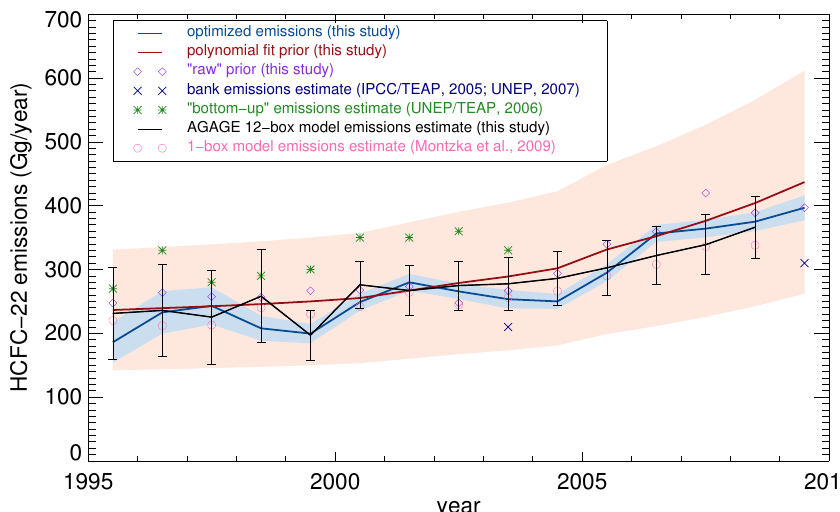
Fig. 3. Global total HCFC-22 emissions. Prior emission estimates using EDGAR v4, the growth rate between 1990–2000 (McCulloch et al., 2003), and HCFC-22 consumption between 2001–2009 (UNEP, 2011) are shown in diamonds. Polynomial fit of these “raw” prior values that we used in our global inversion are shown as a red line with a shaded (pink) 40% uncertainty range. Optimized emissions from this study are shown in blue with our calculated posterior uncertainty. Previously published bank emission estimates (blue crosses) (IPCC/TEAP, 2005; UNEP, 2007), “bottom-up” emission estimates (green stars) (UNEP/TEAP, 2006), 1-box model emission estimates (pink circle) (Montzka et al., 2009), as well as new AGAGE 12-box model emission estimates (black line) are also shown for comparison.